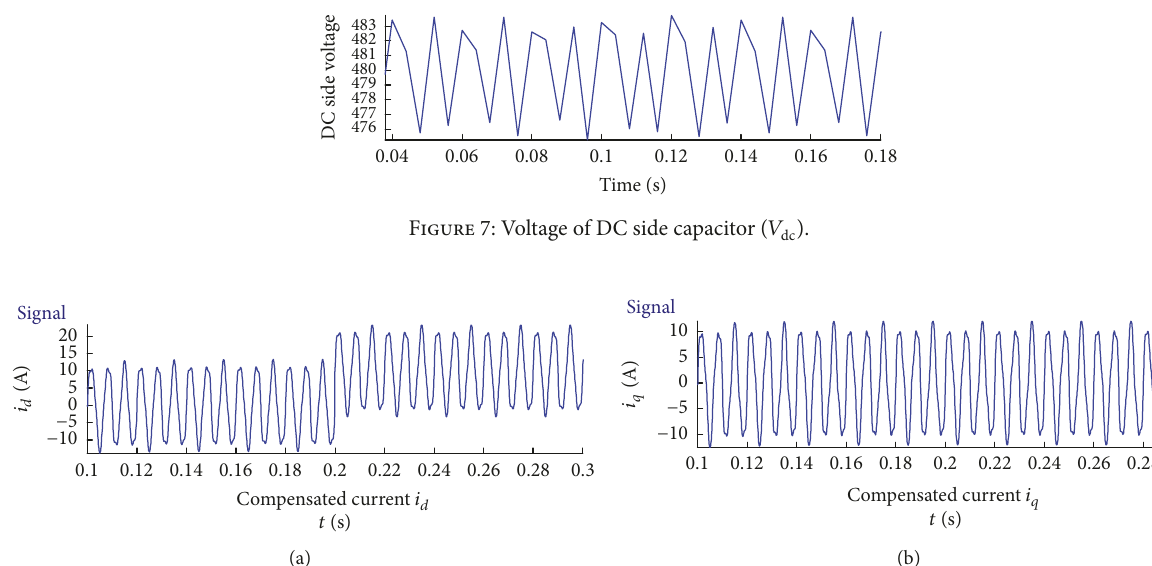
the best effect: it can suppress the 5-order harmonic less than 2% of fundamental. Voltage of DC side capacitor is shown in Figure